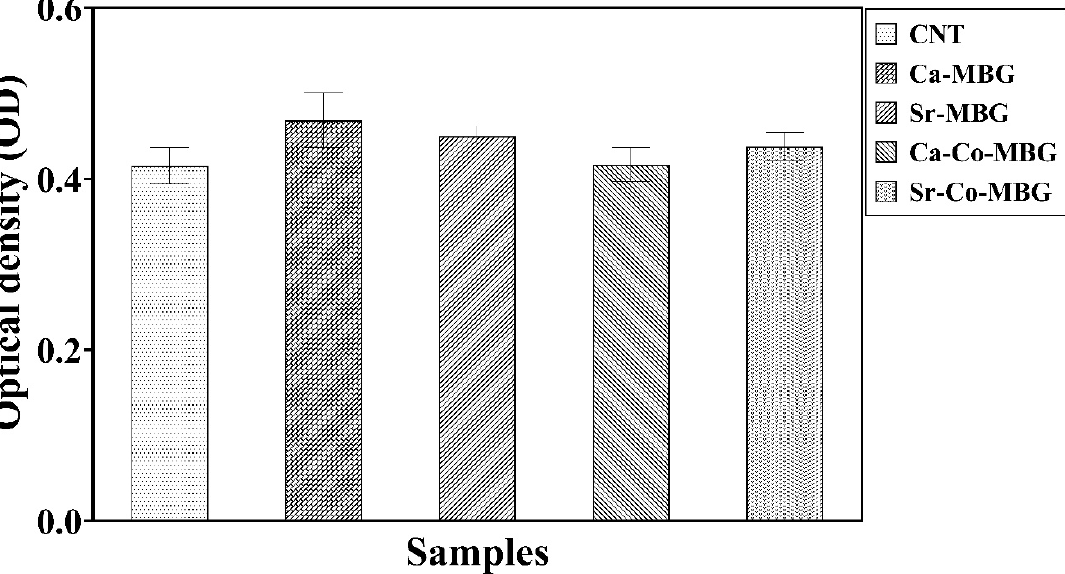
Figure 10. Results of cell attachment study after 3 days. 3.12. In Vitro Angiogenesis Evaluation The optical microscopy images of HUVEC migration upon treatment with MBGs are presented in Figure 12. Based on the obtained results, interestingly, the cell migration is significantly higher in the HUVECs treated with Sr-doped samples in comparison to the other groups. 3.13. Correlation Matrix Presentation To summarize the results of the current study, the correlation matrix table of the obtained results was calculated and shown in Figure 13. Each cell in Figure 13 shows the correlation coefficient between two variables (e.g., the crystallite size vs. the amount of dopants). The range of values for the correlation coefficient is − 1.0000 to 1.0000. In the correlation matrix, a value of zero